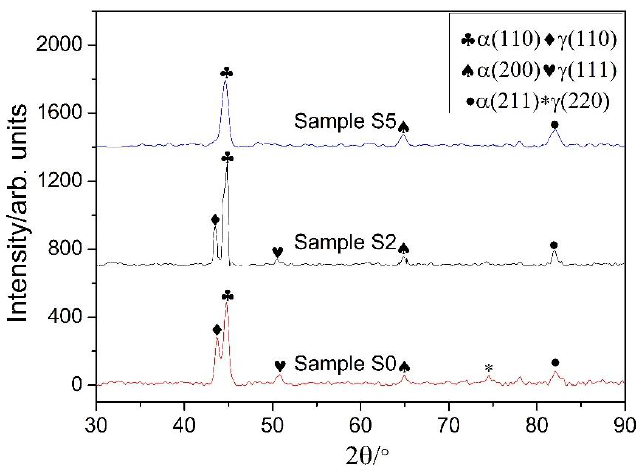
Figure 4. Surface X-ray diffraction (XRD) patterns of 18CrNiMo7-6 steel before and after AWJP.